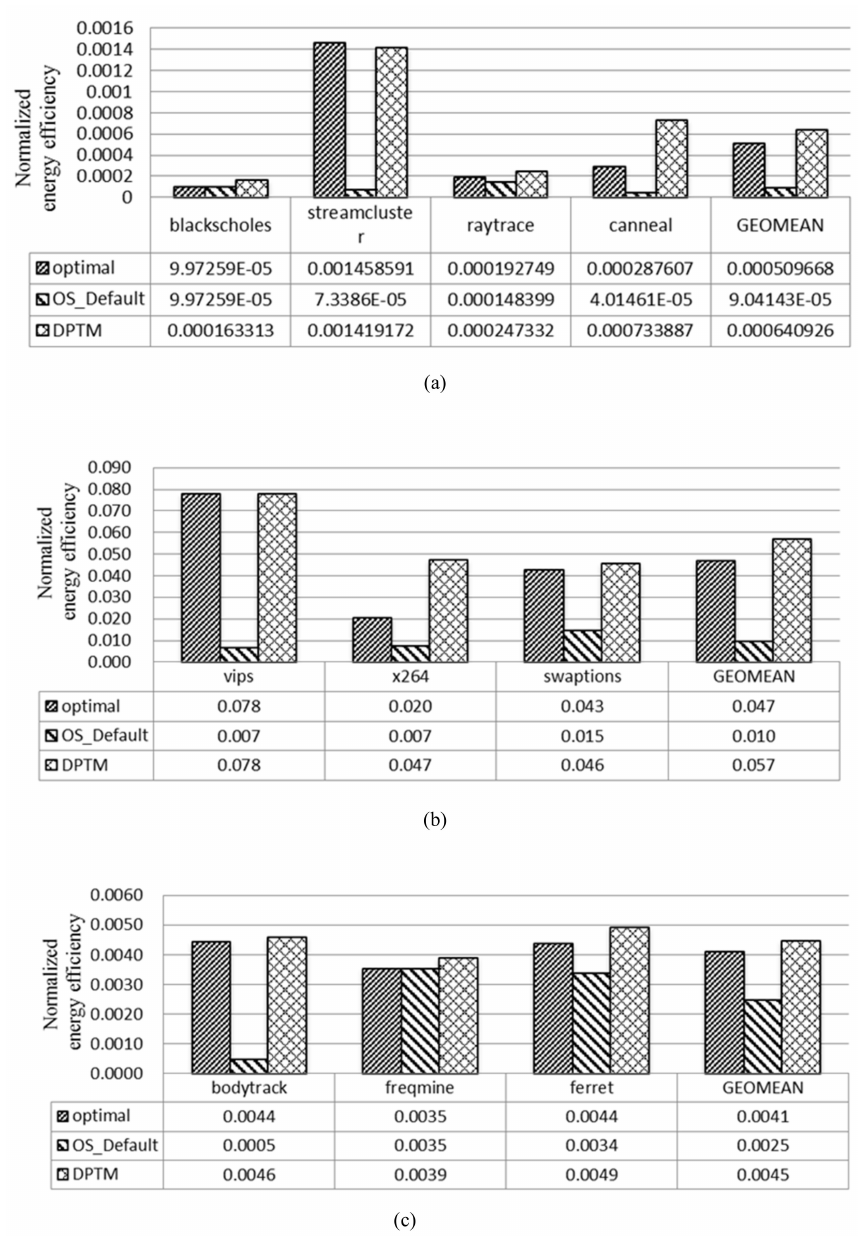
Figure 9. Energy–performance e ffi ciency comparison. ( a ) Benchmark programs: blackscholes, streamcluster, raytrace, and canneal; ( b ) Benchmark programs: vips, x264, and swaptions; ( c ) Benchmark programs: bodytrack, freqmine, and